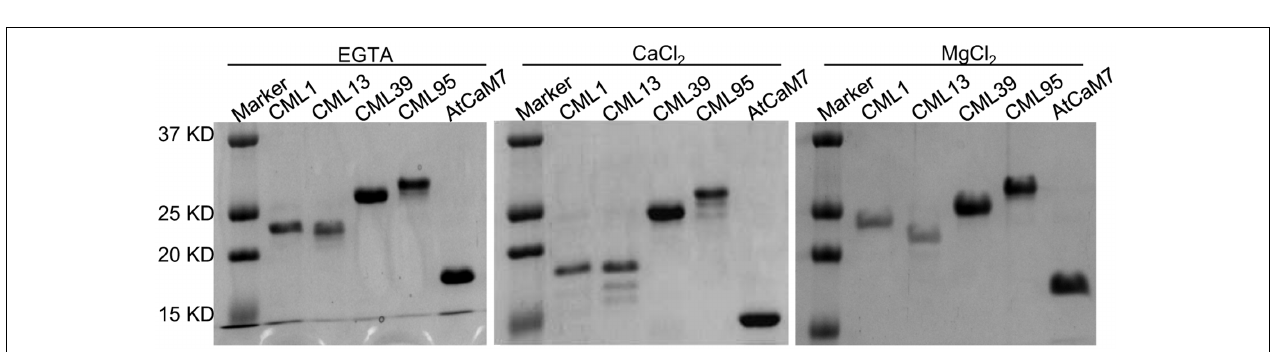
FIGURE 12 | Heat map representation for expression profiles of some selected EF-hand genes in response to stresses. The expression of EF-hand genes were analyzed by qRT-PCR in roots of 12-day-old seedling, after treatment with 200 mM NaCl (salt), 10% PEG 6000, phosphate deficiency ( − Pi), iron deficiency ( − Fe), and zinc deficiency ( − Zn) for 2, 8, and 24 h. The intensities of the color represent the relative magnitude of fold changes (treatment/control) in log2 values of three technical replicates. The asterisks indicate an absolute fold change ≥ 2 and P -value < 0.05 by Student’s t -test. Red color indicates induction, green color indicates repression.